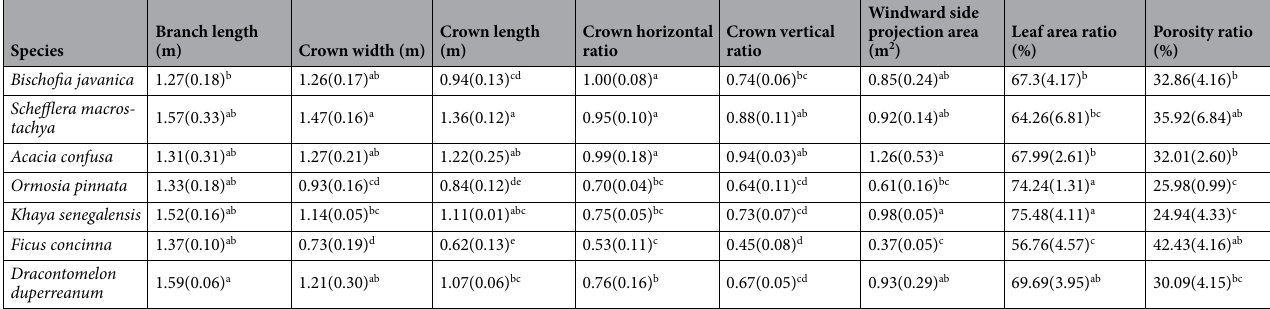
Table 2. The statistics of branch information in 7 species. Values in parentheses are stand deviations. Means followed by the same letter are not different at p = 0.05 (Kruskal–Wallis test). Values sharing the same superscript letters are not significantly